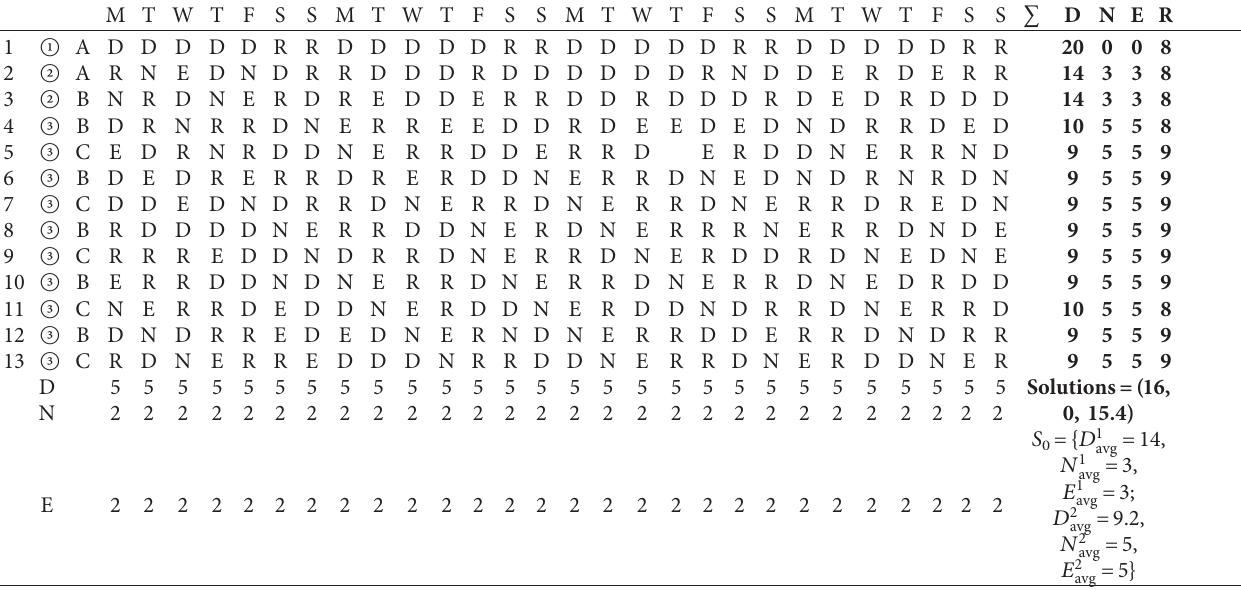
Table 12: A roster obtained by algorithm NSGAII-MOGWO.